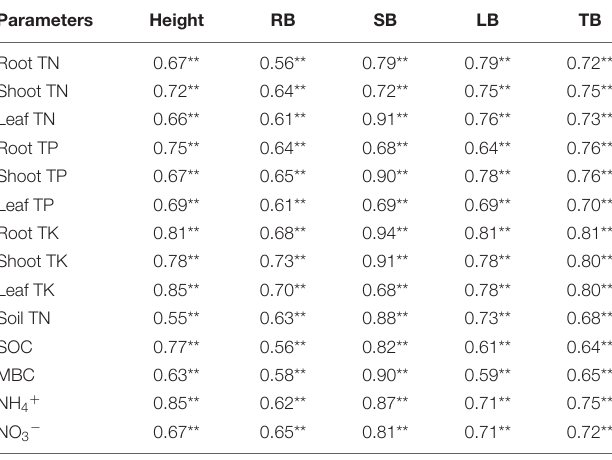
TABLE 2 | Pearson correlations analyses between plant parameters and soil